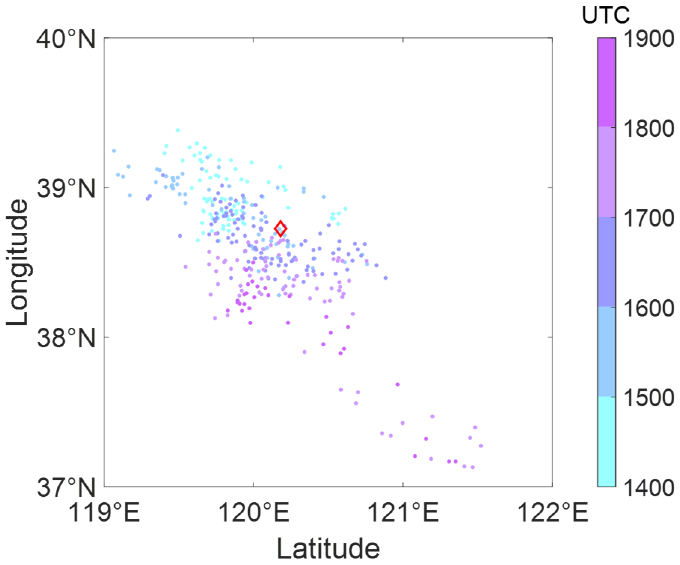
Figure 10. WWLLN lightning distribution, colored dots show WWLLN location results, red diamond indicates parent CG.